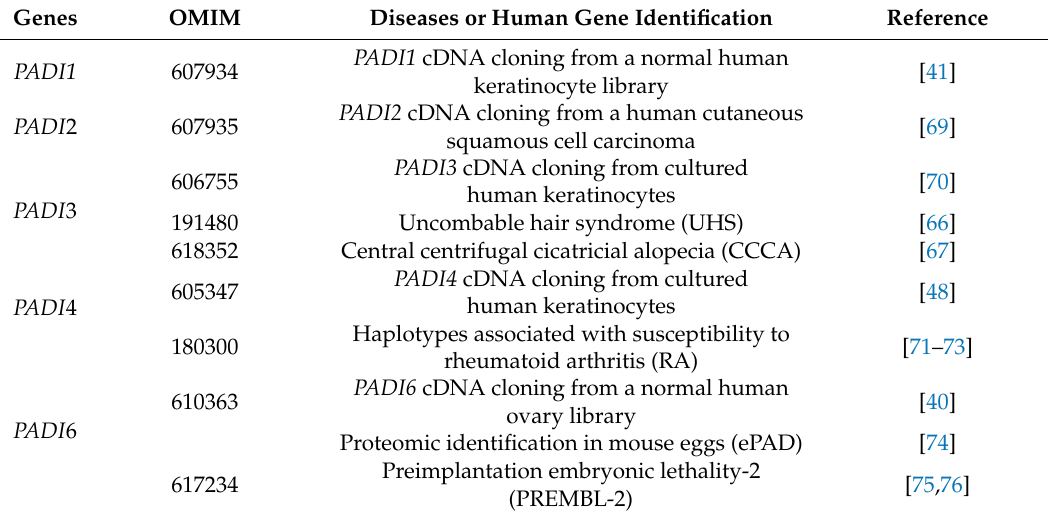
Table 3. PADI genes and human genetic